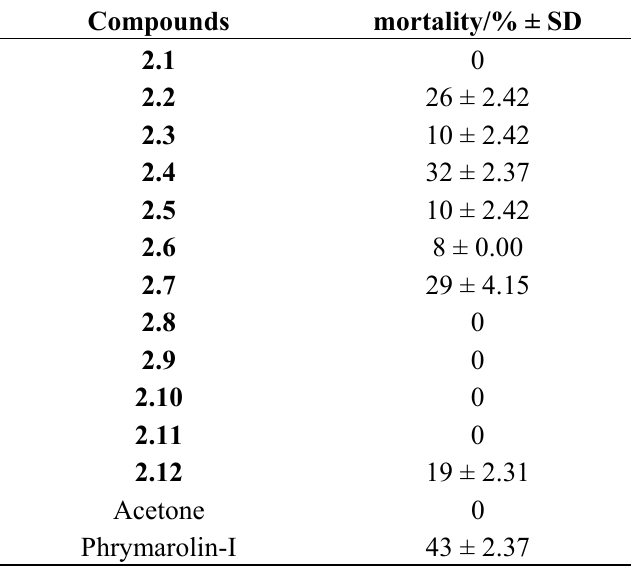
Table 2. Insecticidal activity of triazole